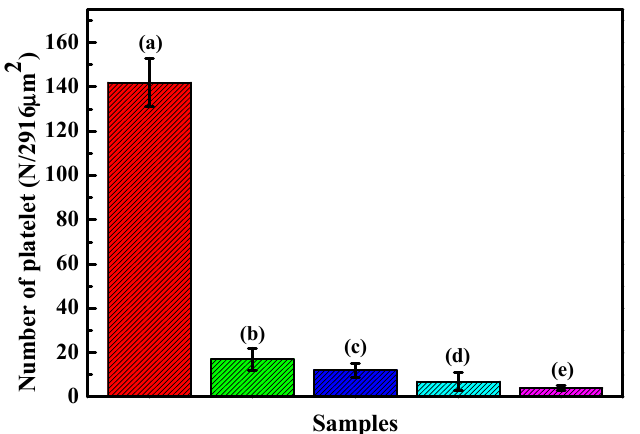
Figure 12. Statistical analysis of the adhered platelet number on the substrate of the uncoated 316L SS and HfC coatings deposited at different bias voltages. ( a ) 316L SS, ( b ) 0 V, ( c ) − 100 V, ( d ) − 150 V, and ( e ) − 200 V.